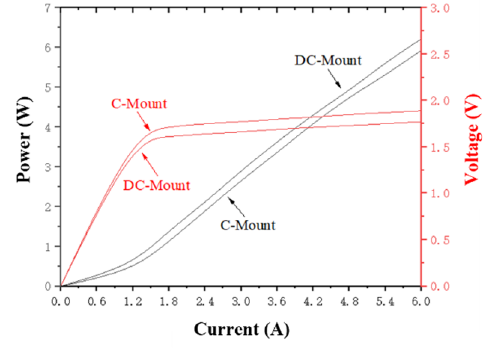
Figure 9. P-I-V characteristics comparison curve.